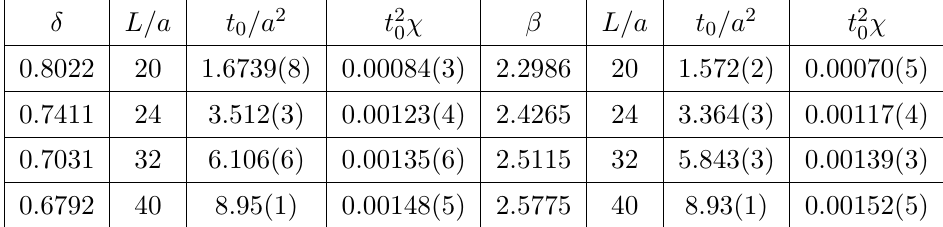
Table 1 . The scale t 0 and topological susceptibility with the topological (left 4 columns) and Wilson plaquette action (right 4